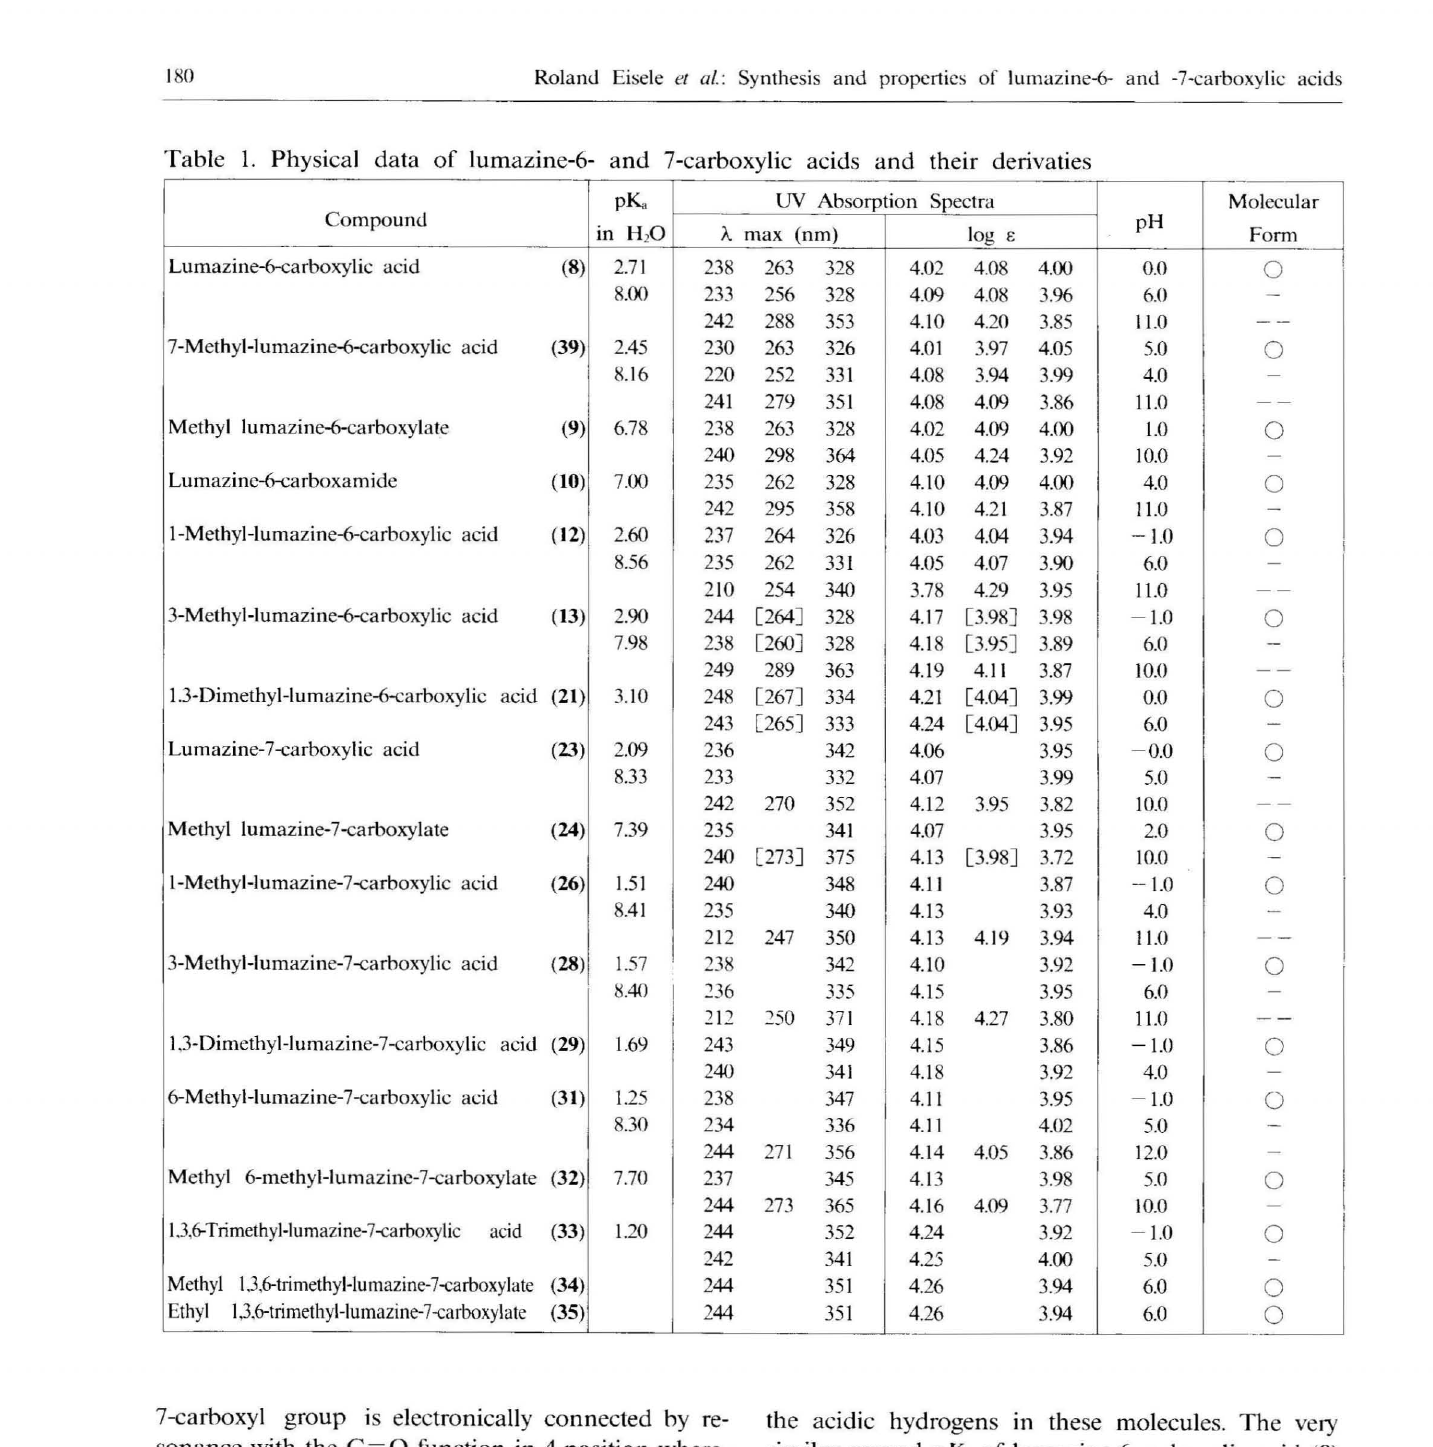
Table 1. Physical data of lumazine-6- and 7-carboxylic acids and their derivaties pKa UV Absorption Spectra Molecu Compound in H 2 O "- max (nm) log g